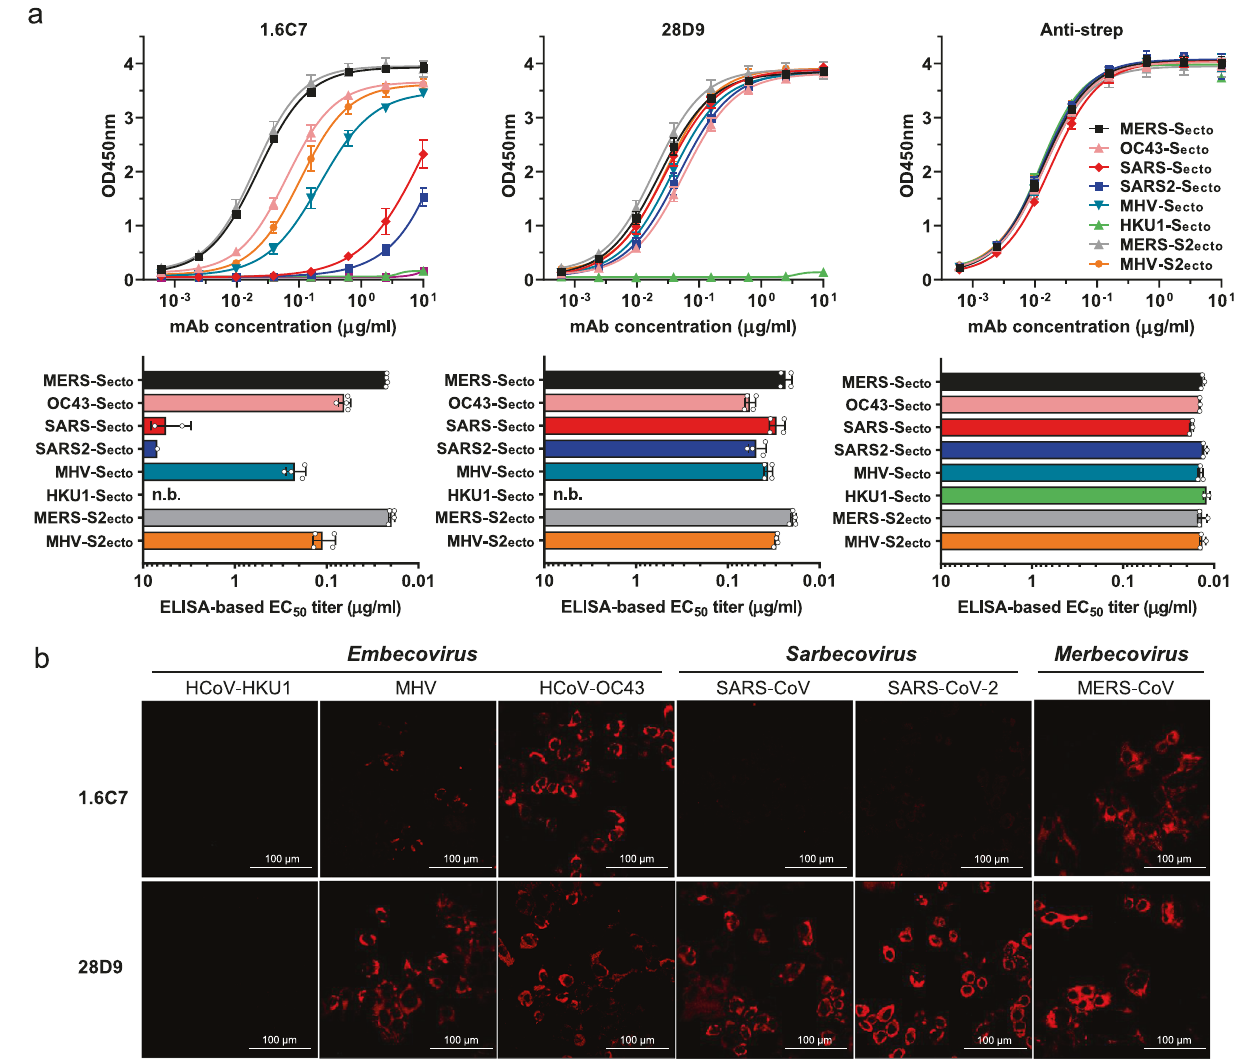
Fig. 1 Cross-reactivity of human monoclonal antibodies 28D9 and 1.6C7 to spike proteins of viruses in the Betacoronavirus genus. a ELISA binding curves (upper panels) and corresponding ELISA-based half-maximal effective concentrations (EC 50 ) titers (lower panels) of mAbs 28D9 and 1.6C7 to Strep-tagged spike ectodomains (S ecto ) and S2 ectodomains (S2 ecto ) of betacoronaviruses from different subgenera including MERS-CoV (subgenus Merbecovirus), SARS-CoV and SARS-CoV-2 (subgenus Sarbecovirus ) , HCoV-OC43, HCoV-HKU1 and MHV (subgenus Embecovirus), coated at equimolar concentrations. Anti-strep mAb targeting the Strep-tagged antigens was used to corroborate equimolar plate coating. n.b., no binding. Graph bars represent the average ± SD. Hollow circles represent individual data points for n = 2 biological replicates and 2 technical replicates. Source data are provided as a Source Data fi le. b Binding of mAbs 1.6C7 and 28D9 to HEK-293T cells expressing GFP-tagged membrane-anchored full-length spike proteins of MERS-CoV, SARS-CoV, SARS-CoV-2, HCoV-OC43, HCoV-HKU1 and MHV detected by immuno fl uorescence assay. Cell nuclei in the overlay images were visualized by DAPI. The fl uorescence images were recorded using a Leica SpeII confocal microscope. Representative images from n = 2 biological replicates. Scale bars are 100 μ